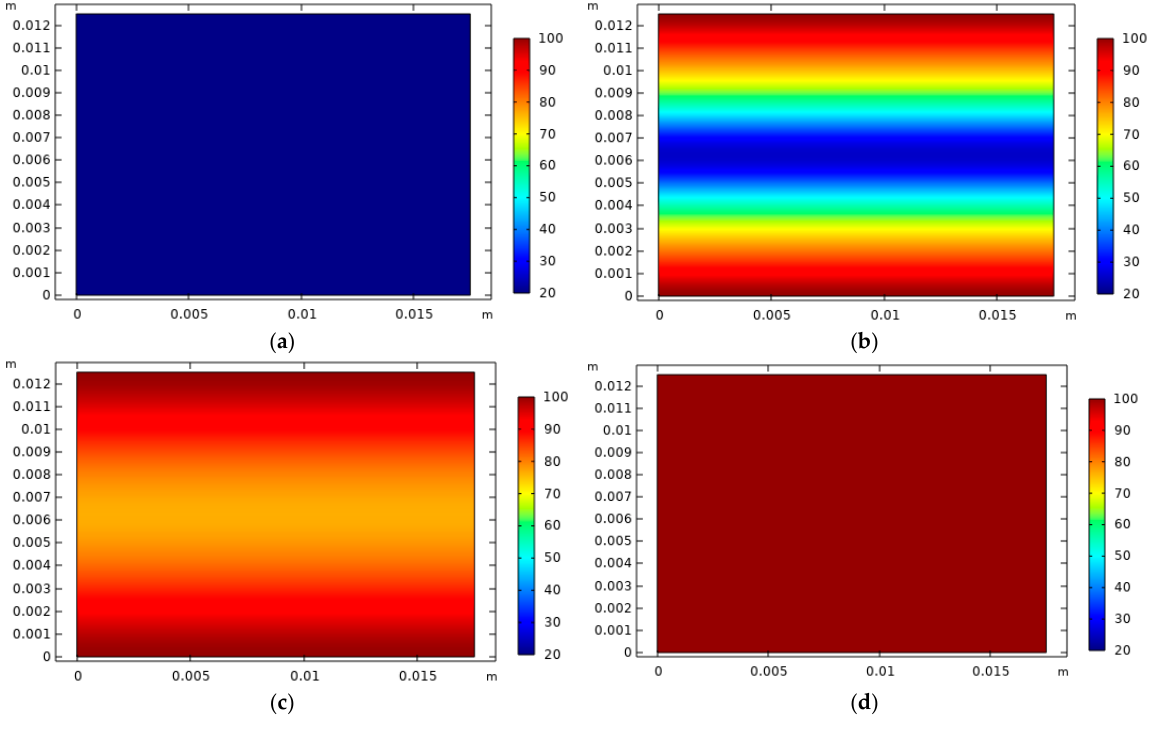
Figure 6. The degree of saturation of the sample at different times (( a ) t = 0, ( b ) t = 200 min, ( c ) t = 500 min, ( d ) t = 1200 min) (Path AB’C’, hydration stage AB’). ( c ) t = 500 min, ( d ) t = 1200 min) (Path AB’C’, hydration stage